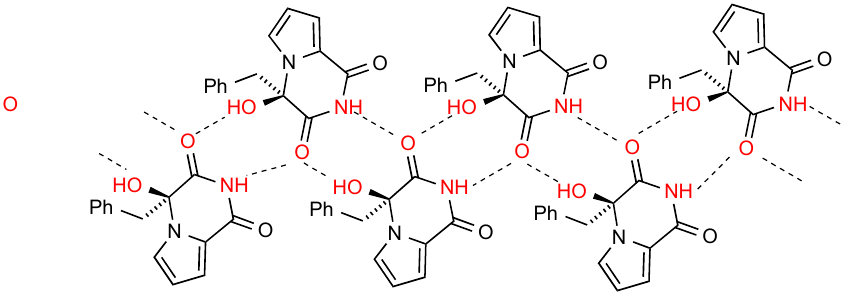
Figure 79. Structure adopted by compound 277.